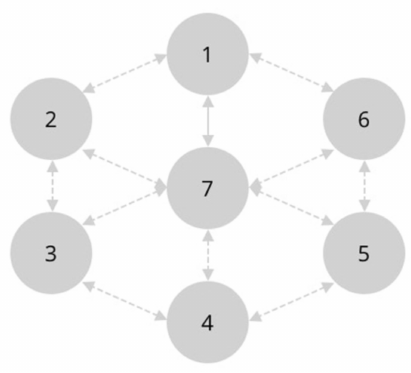
Figure 3. Blockchain Nodes